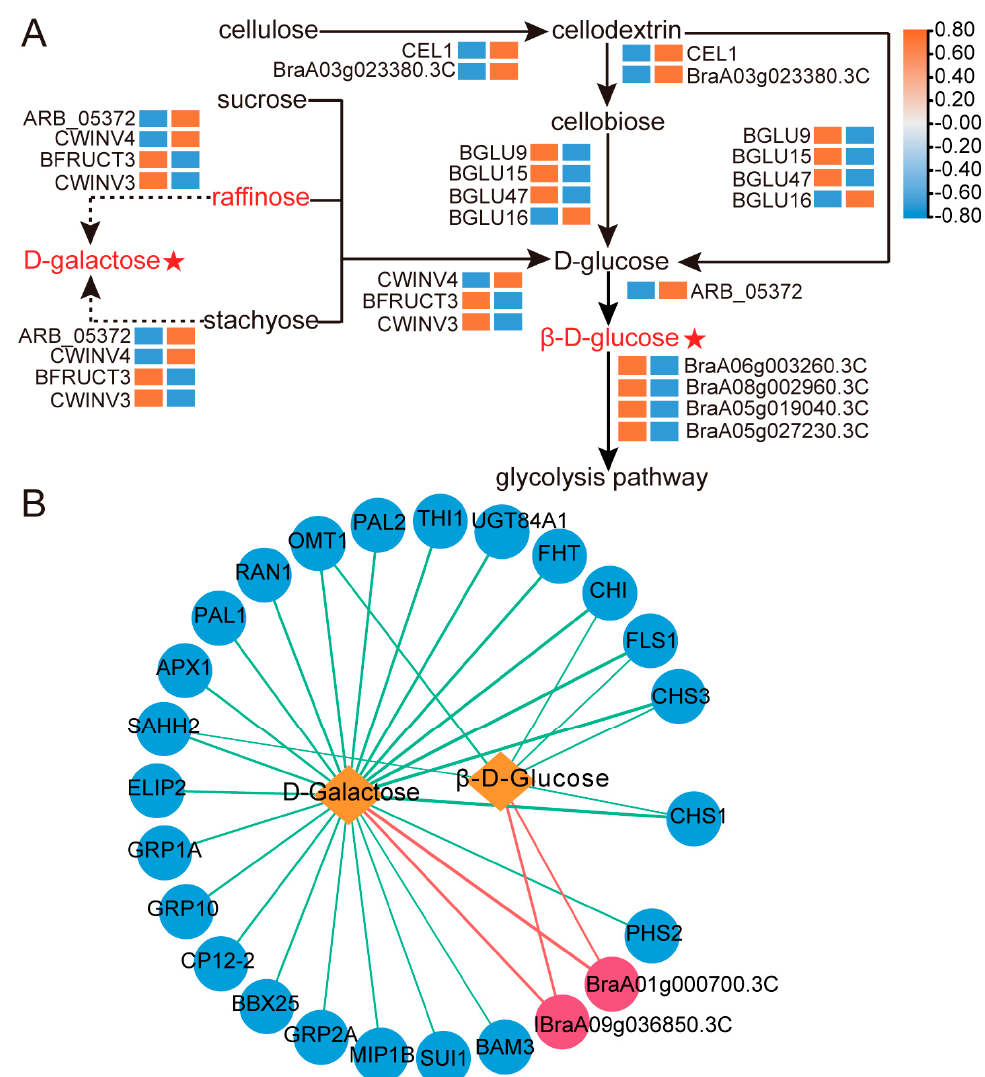
Figure 6. Accumulation pathway and Interact network of D-galactose and β -D-glucose. ( A ) Accu- mulation pathway. Metabolites upregulated or undifferentiated at 46 DAP are indicated in red and black. The red asterisk indicates a biomarker. The left and right columns of the heatmap represent 34 DAP and 46 DAP, respectively. Genes upregulated or downregulated are shown in orange and blue, respectively. The heatmap was based on the FPKM values of the DEGs. ( B ) Interact network. The circles with red and blue represent up-regulated and down-regulated DEGs, respectively. The orange diamond shape represents the two main accumulated sugars. The positive and negative correlations are represented by red and green lines, respectively. The thicker the line, the higher the correlation.